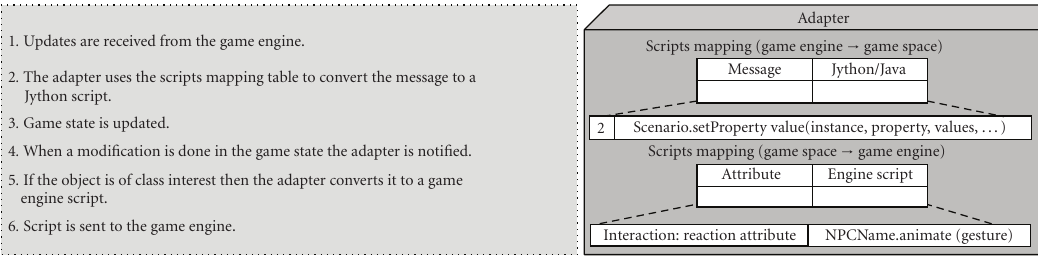
Figure 3: Communication between the game engine and the game